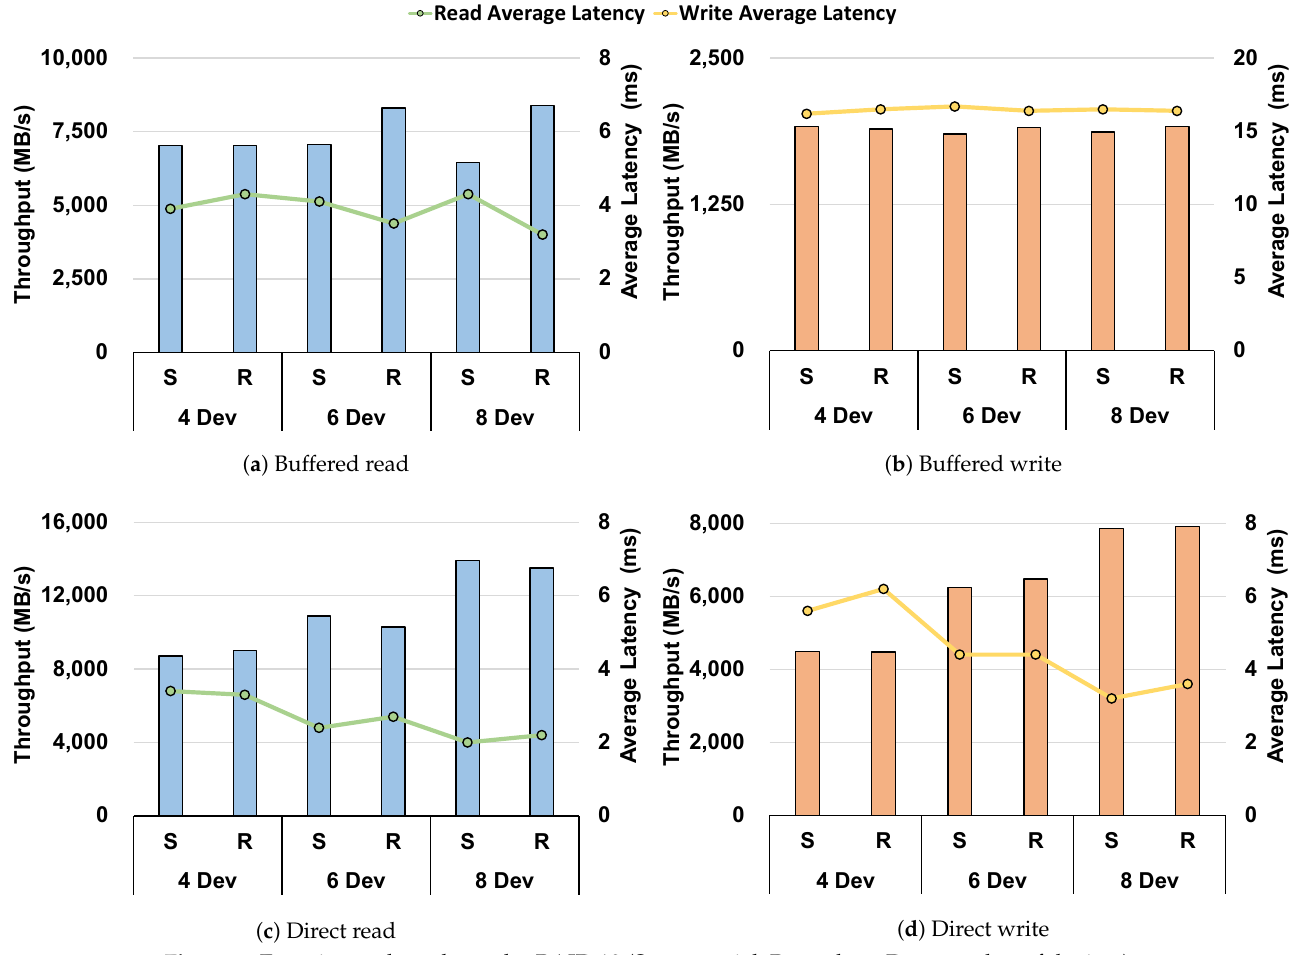
Figure 3. Experimental results under RAID 10 (S: sequential, R: random, Dev: number of